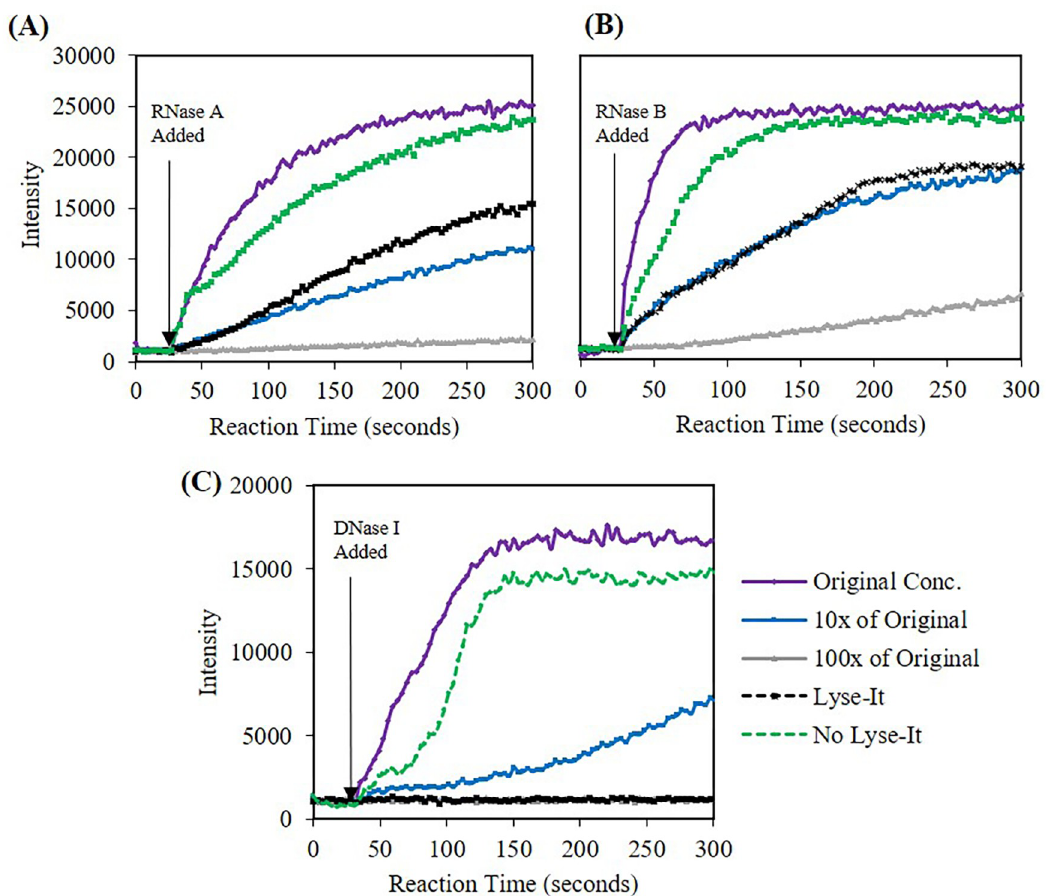
Fig 9. Fluorescent intensity at 520 nm (RNase A/B) and 556 nm (DNase I) versus time for nucleases in DI water lysed with and without Lyse-It at 50% power for 60 seconds. The concentration of lysing was undertaken with the highest concentration of nuclease. Each Pre was a 10-fold dilution from the starting concentration. (A) 20 pM starting RNase A (B) 46 pM starting RNase B, (C) starting 10.5 nM DNase I. When Lyse-It is used, the activity of the nuclease is significantly reduced as compared to without the use of